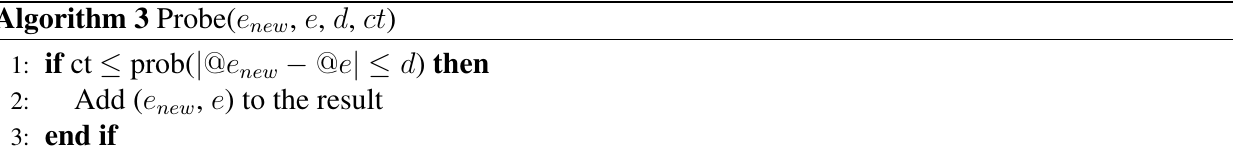
Algorithm 3 Probe( e